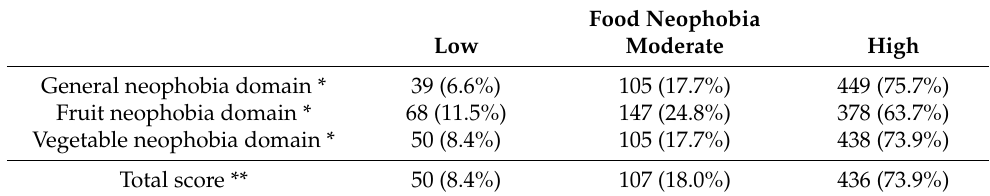
Table 1. Distribution of the sample according to food neophobia classification in children with ASD ( n = 593; Brazil, 2020–2021).